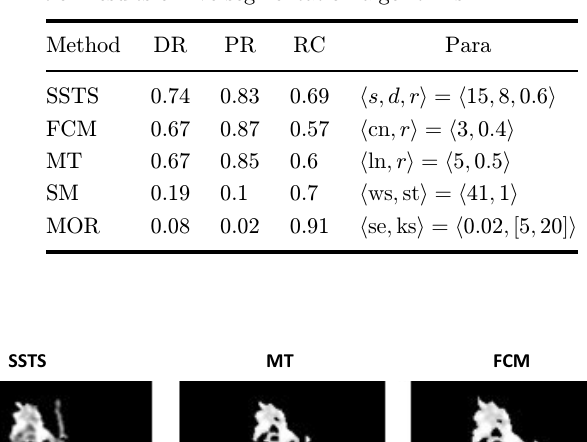
Table 2. Optimal parameter settings and segmenta- tion results of ¯ve segmentation algorithms.